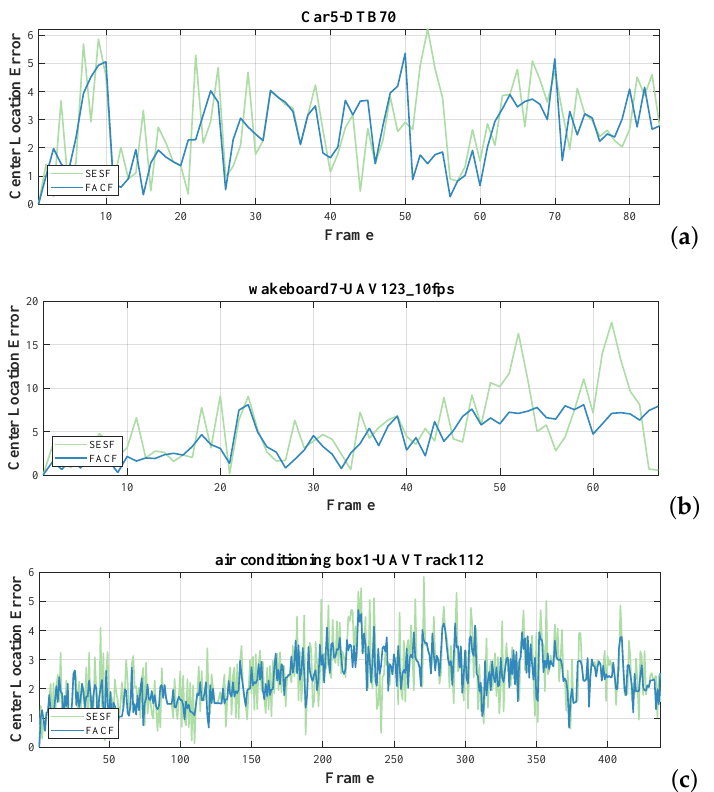
Figure 4. Center location error (CLE) comparison of the single exponential smoothing forecast method (SESF) and the proposed tracker (FASF) on three challenging seqeuences. From top to bottom are ( a ) Car5 from DTB70 [25], ( b ) wakeboard7 from UAV123_10fps [26], and ( c ) air conditioning box1 from UAVTrack112